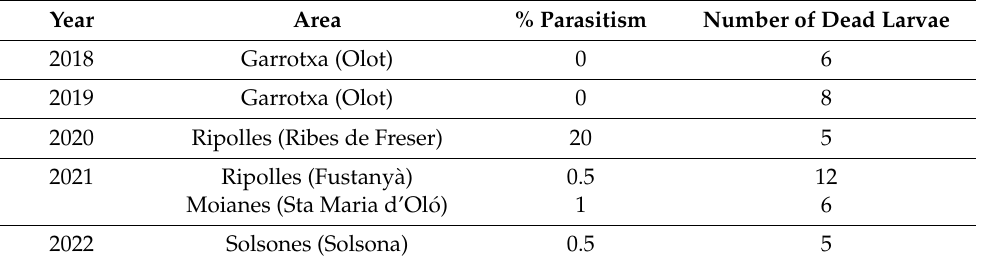
Table 3. Percentage of parasitism and number of dead larvae due to unidentified agents of the collected larvae in the different regions of Catalonia and in different years.